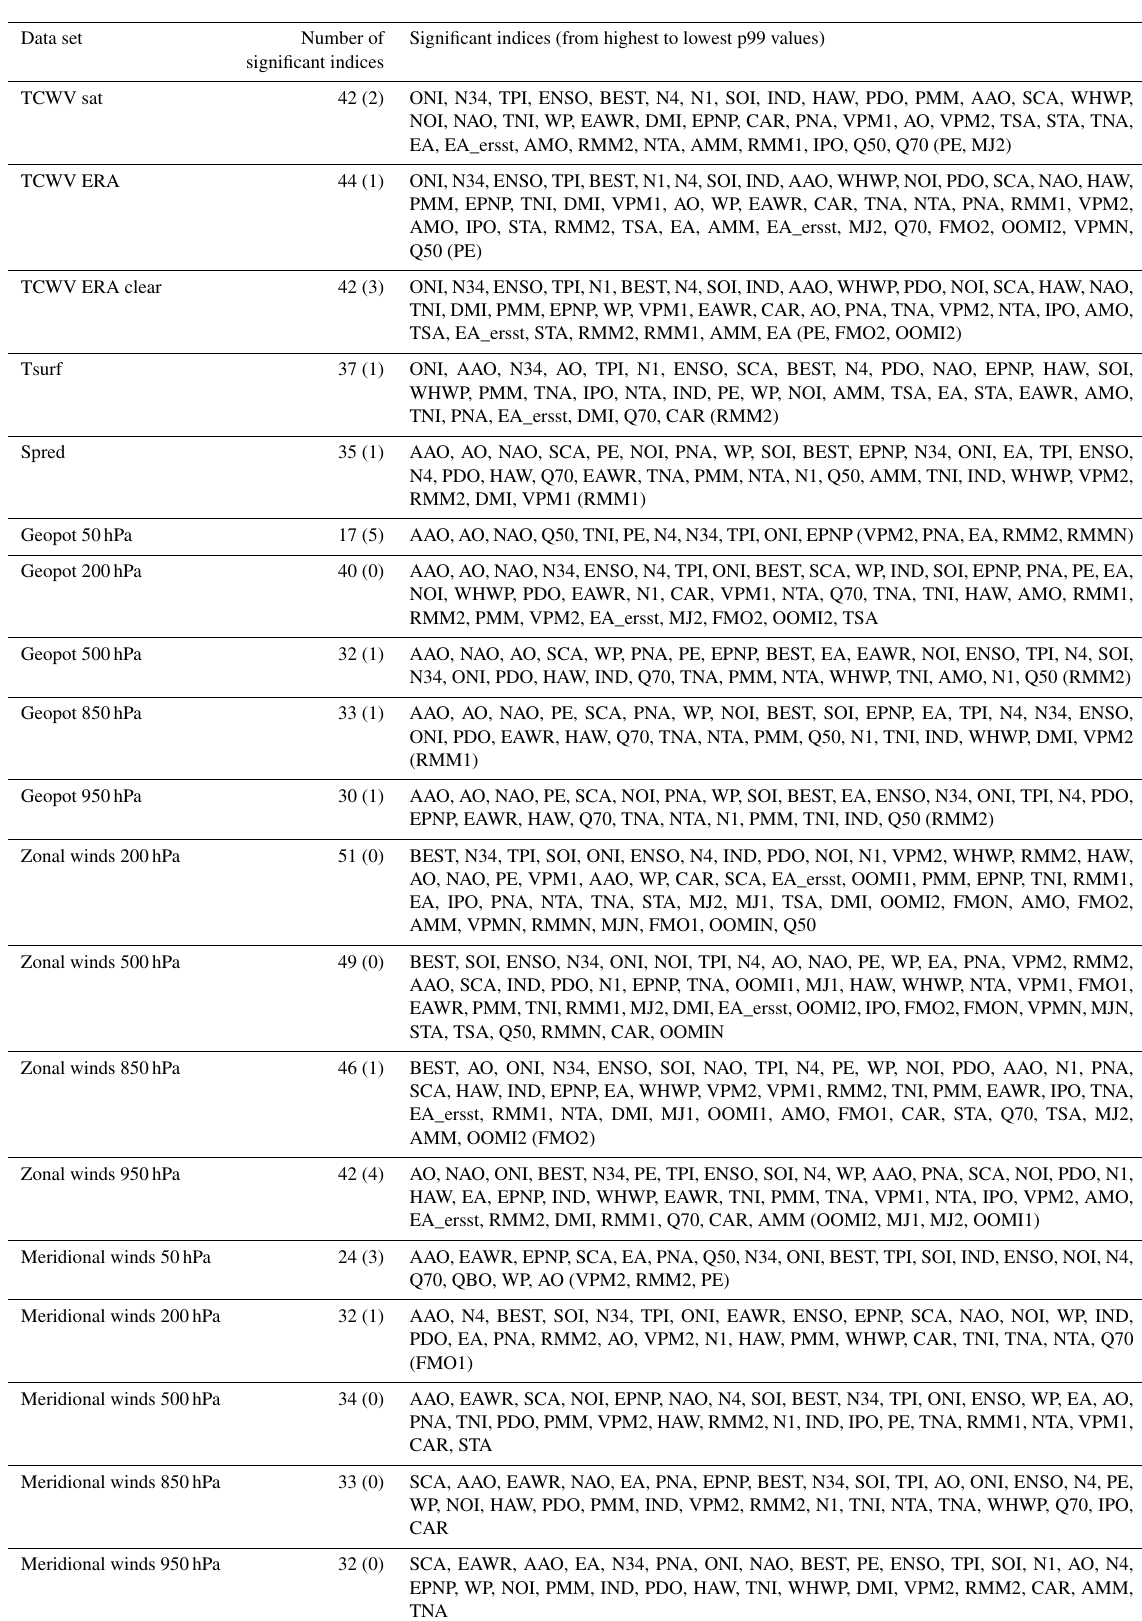
Table A1. Significant indices for all data sets (indices with p99 values below threshold but shift ratios < 0.8 are indicated in brackets). Data set Number